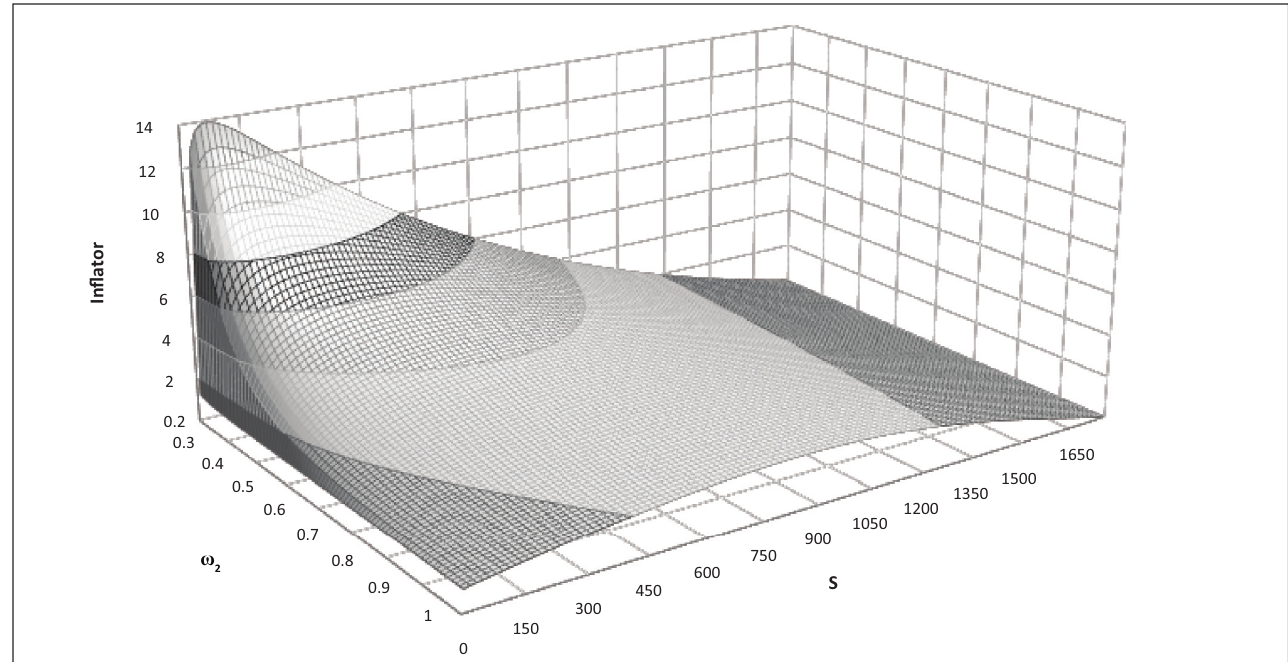
FIGURE 8: Surface plot showing the impact of ω